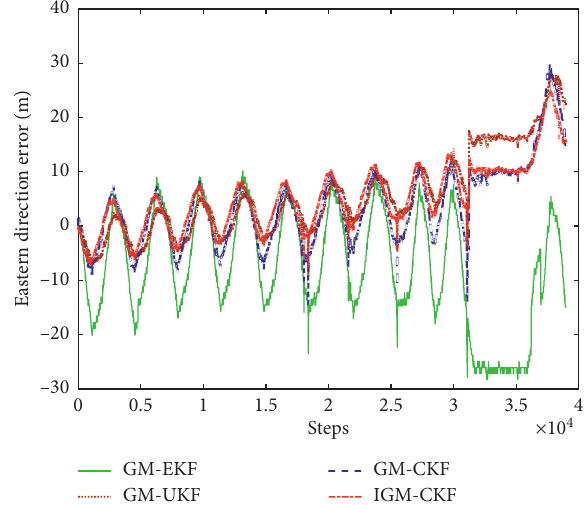
Figure 5: Comparison of the northern direction errors.